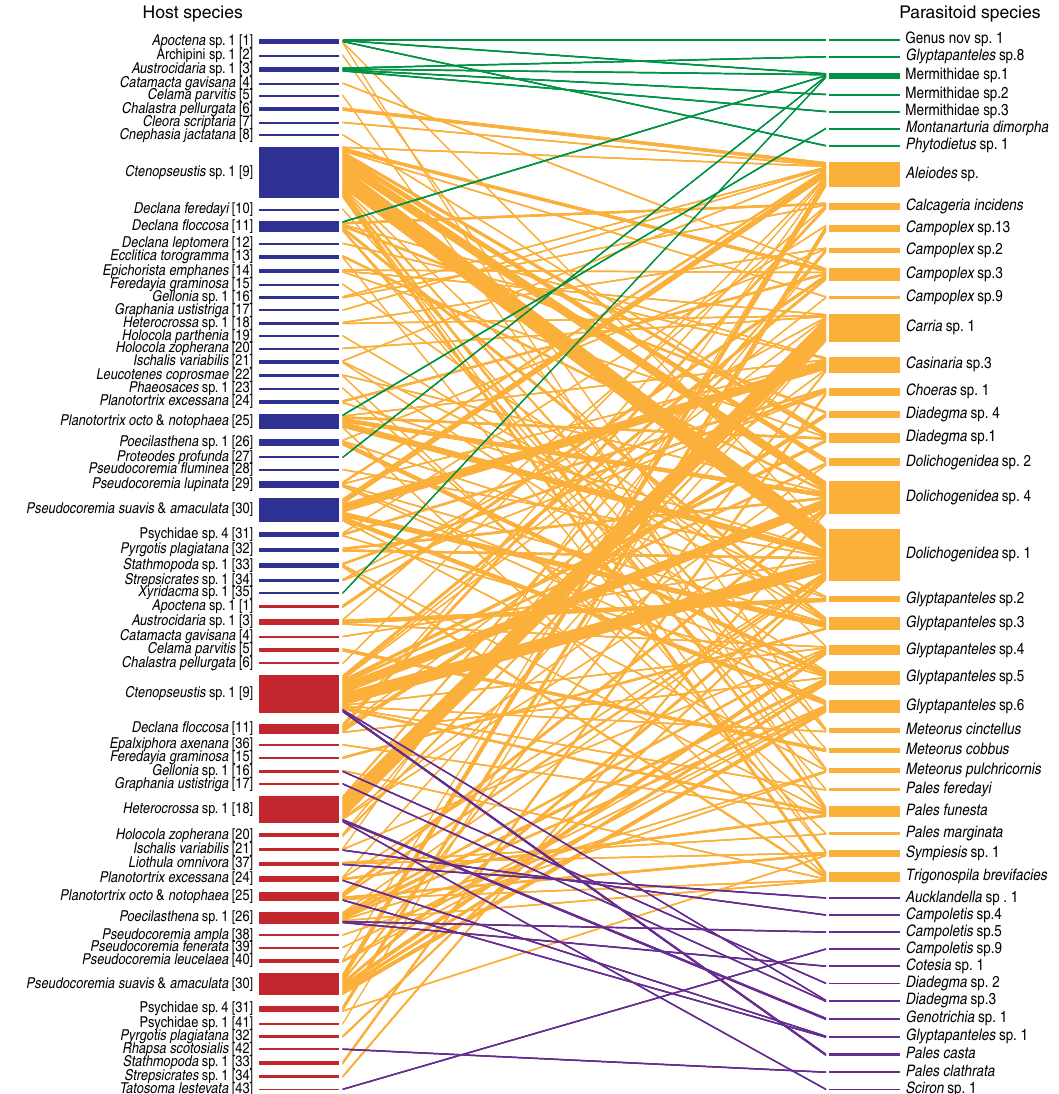
Figure 2 | Regional metaweb built from quantitative food-web data. Data were collected at habitat edges between native forest and exotic plantation forest and are pooled across eight training sites and seven sampling dates. Bars on the left represent herbivore host species in native forest (blue) or plantation forest (red), and bar thickness is proportional to number of parasitism events (358 total parasitism events from 2725 individual hosts reared). Bars on the right represent parasitoid species, and lines connecting parasitoids and host species denote parasitism, with parasitoids attacking hosts in native forest only (green), plantation forest only (purple) or both forest types (yellow). Parasitoid bar thickness is proportional to attack rate 56 . Numbers adjacent to host names correspond to the host numbers in Figure